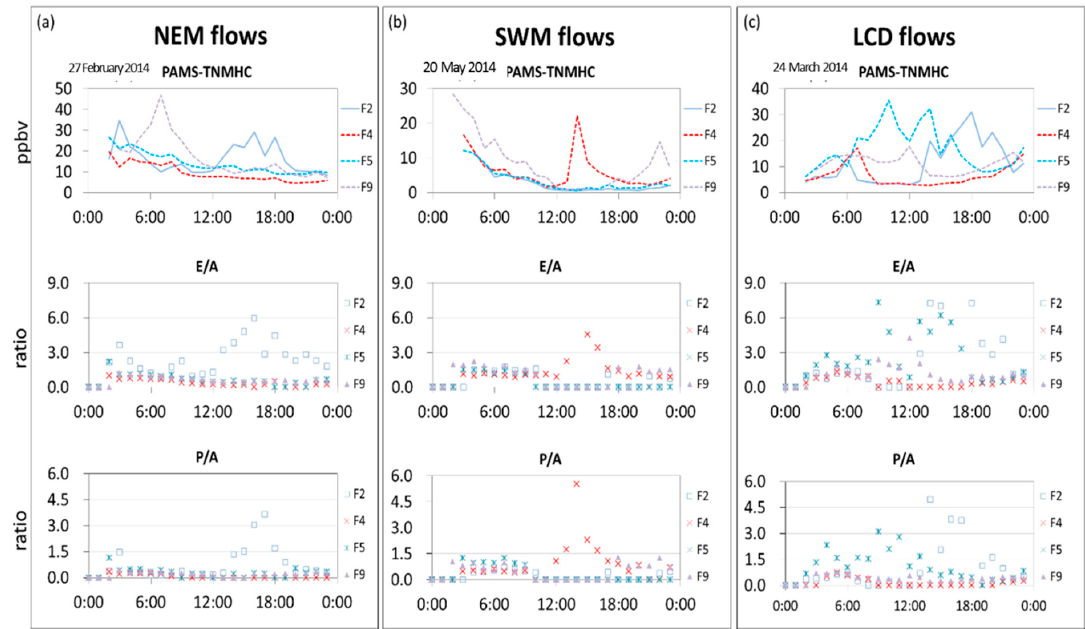
Figure 5. Typical cases under the three wind patterns to show a simultaneous increase in PAMS-TNMHC mixing ratios and two ratio indicators (ethene/ethyne (E/A) and propene/ethyne (P/A)) to suggest the detection of petro-emissions. ( a ) northeast monsoonal (NEM) flow; ( b ) southwest monsoonal (SWM) flow; ( c ) local circulation/diffusion (LCD) flow.